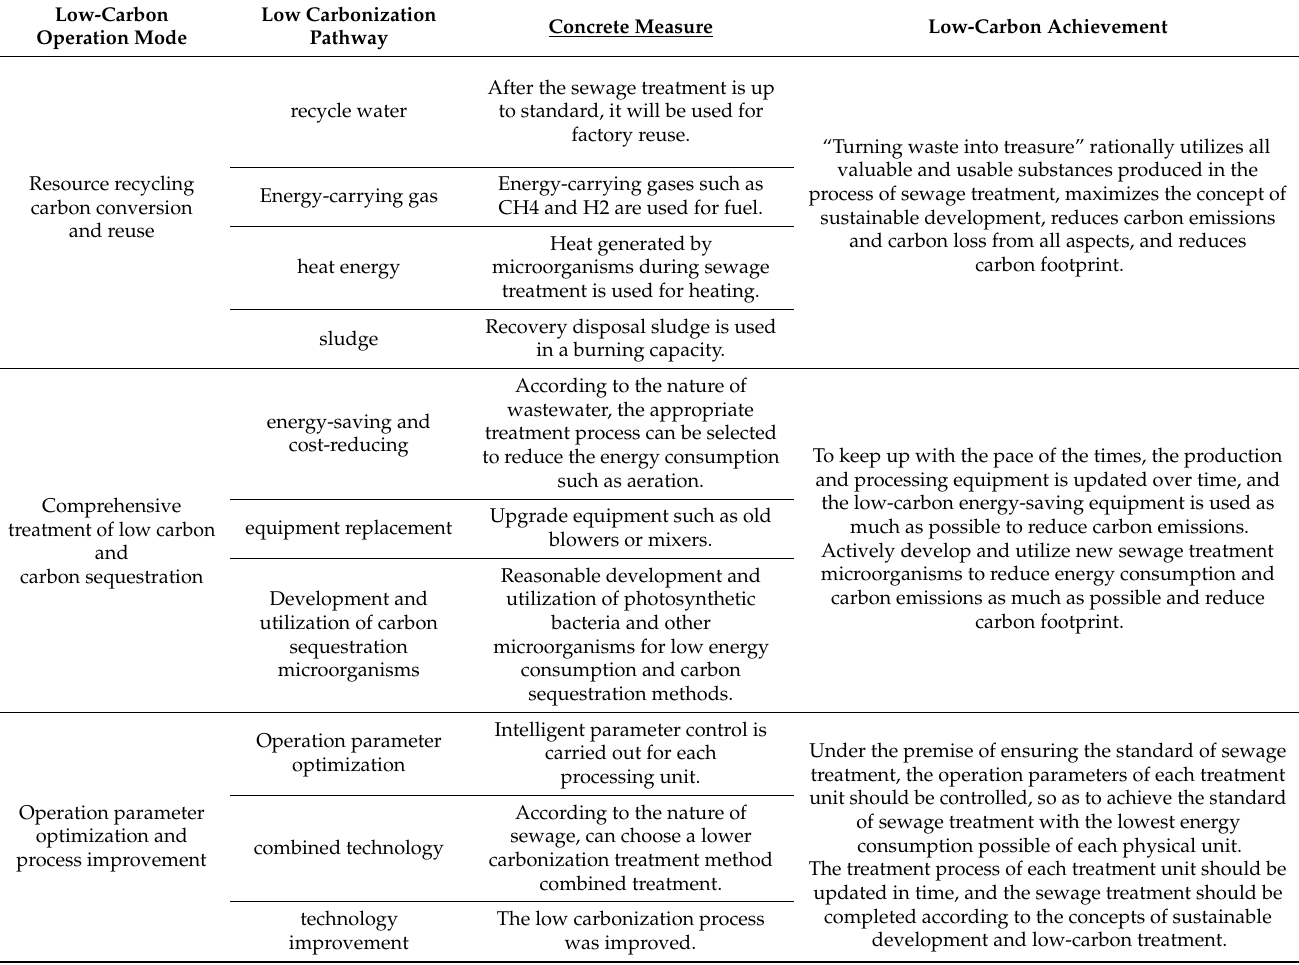
Table 2. Discussion and summary of low-carbon operation modes in the sewage treatment